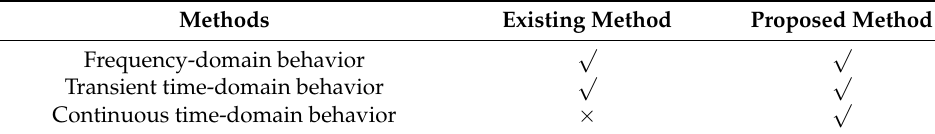
Table 1. Comparison of existing and proposed method.